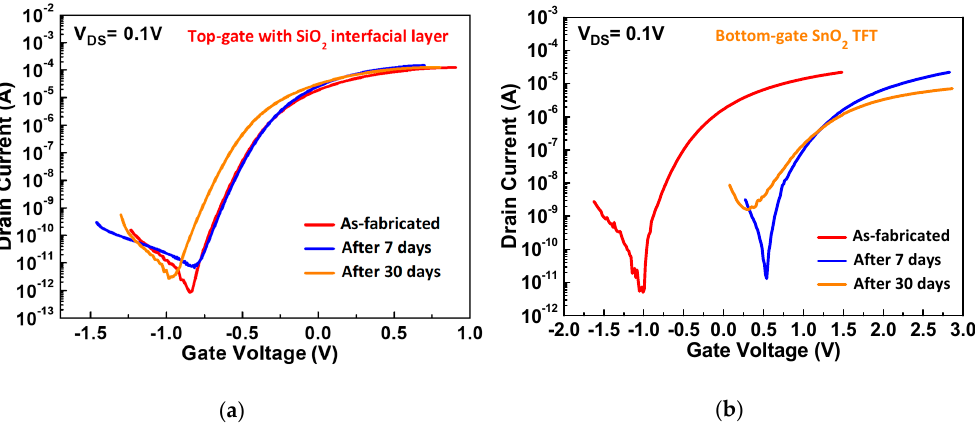
Figure 6. The I DS -V GS characteristics of the ( a ) top-gate and ( b ) bottom-gate SnO 2 TFT devices measured as-fabricated after 7 days and after 30 days of exposure to ambient air.